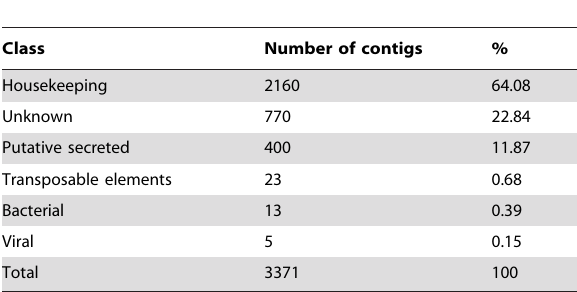
Table 2. Functional classification and relative abundance of the TAG peptides.